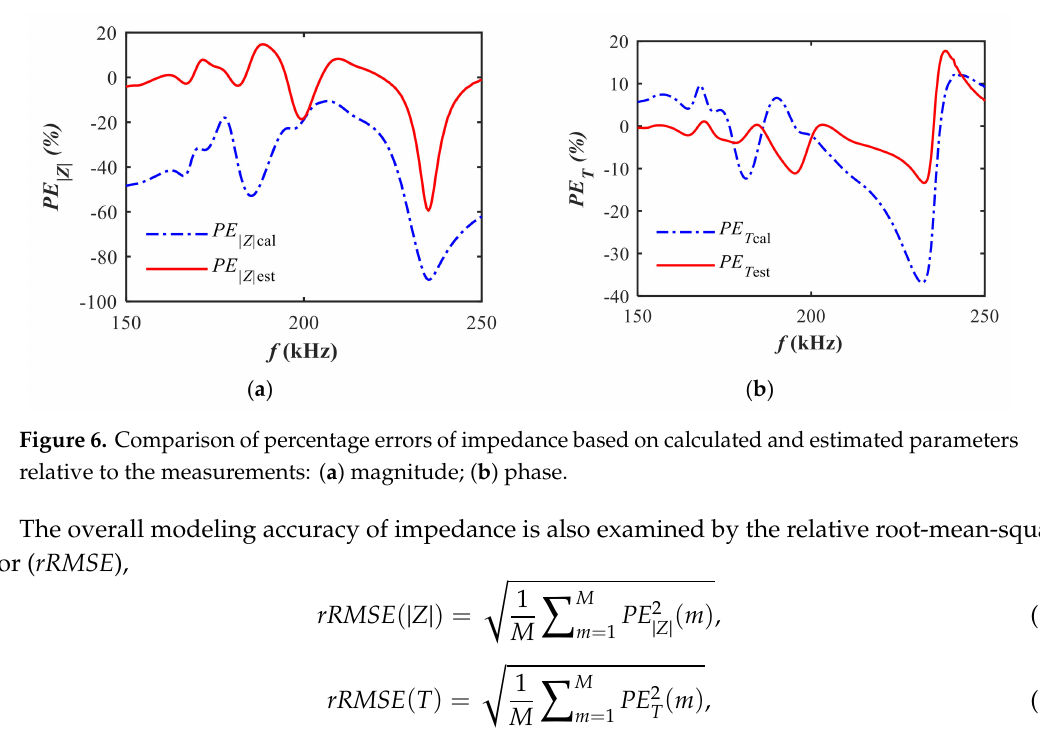
Figure 5. Comparison of model-based impedance based on calculated and estimated parameters: ( a ) magnitude; ( b ) phase.